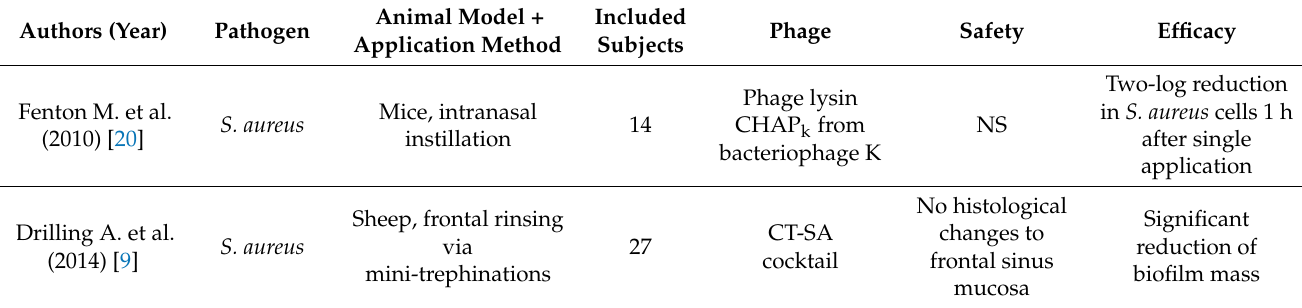
Table 3. Overview of animal studies investigating the safety and efficacy of bacteriophages or phage-derived enzymes in the treatment of chronic